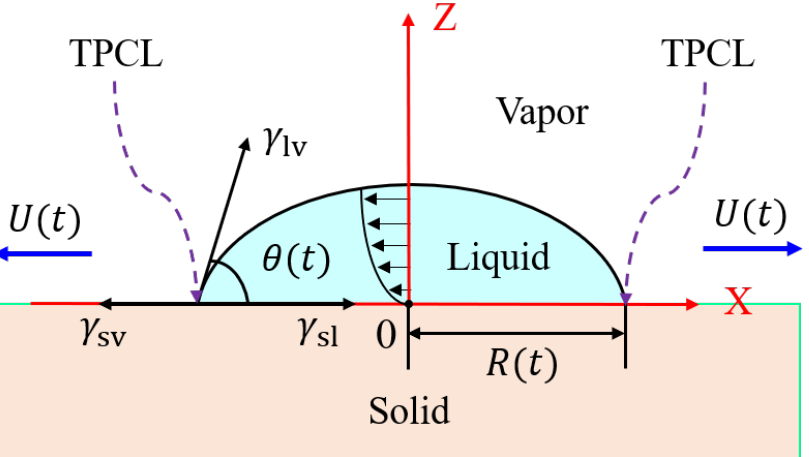
Figure 3. Typical schematic of the spreading of a droplet on a solid surface in the vapor medium, where 𝑅(𝑡) is the instantaneous spreading radius, 𝜃(𝑡) is the dynamic contact angle, and 𝑈(𝑡) is the velocity of three-phase contact line (TPCL) at 𝑡 , 𝛾 sv , 𝛾 sl and 𝛾 lv are the solid – vapor, solid – liquid, and liquid – vapor interfacial tensions, respectively [44].